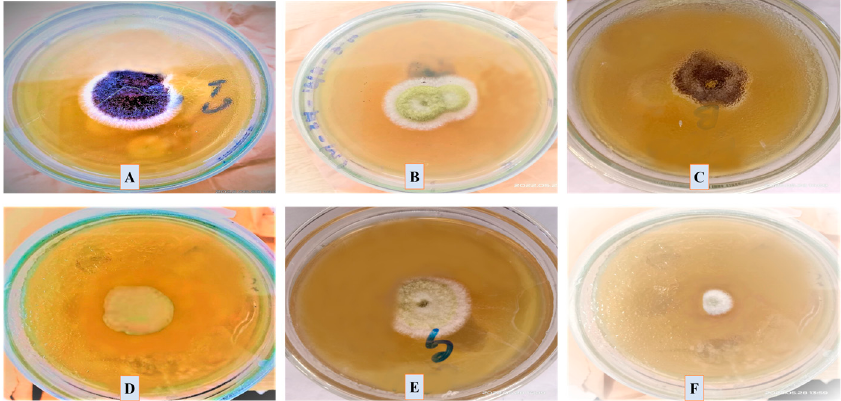
Figure 13. Mycelial growth and Zone of inhibition of various fungal strains. ( A ) A. flavus , ( B ) F. solani , ( C ) A. niger , ( D ) C. albicans , ( E ) M. racemosus , ( F ) control ( Ampicillin ) against Ag 2 ONPs.